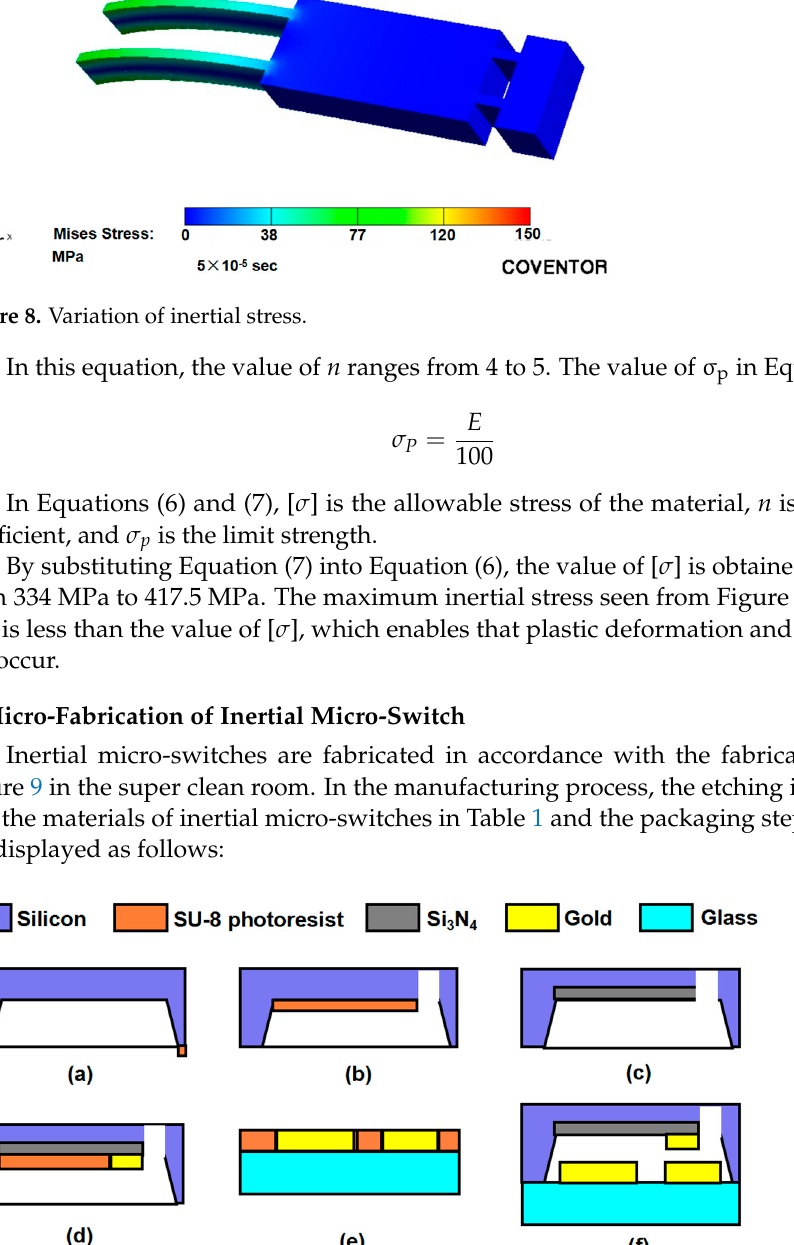
Figure 9. Fabrication flow. ( a ) Spin ‐ coasting, patterning ‐ exposure and etching silicon. ( b ) Removing of photoresist and etching silicon. ( c ) low ‐ pressure chemical vapor deposition. ( d ) Patterning ‐ exposure and sputtering gold. ( e ) Spin ‐ coasting, patterning ‐ exposure and sputtering gold. ( f ) Anodic bonding.